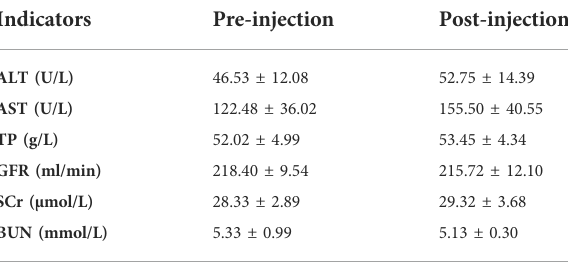
TABLE 1Serumbiochemical indicatorspost cRGD-PLGA-Fe 3 O 4 -PFOB NPs injection (50 mg/ml).